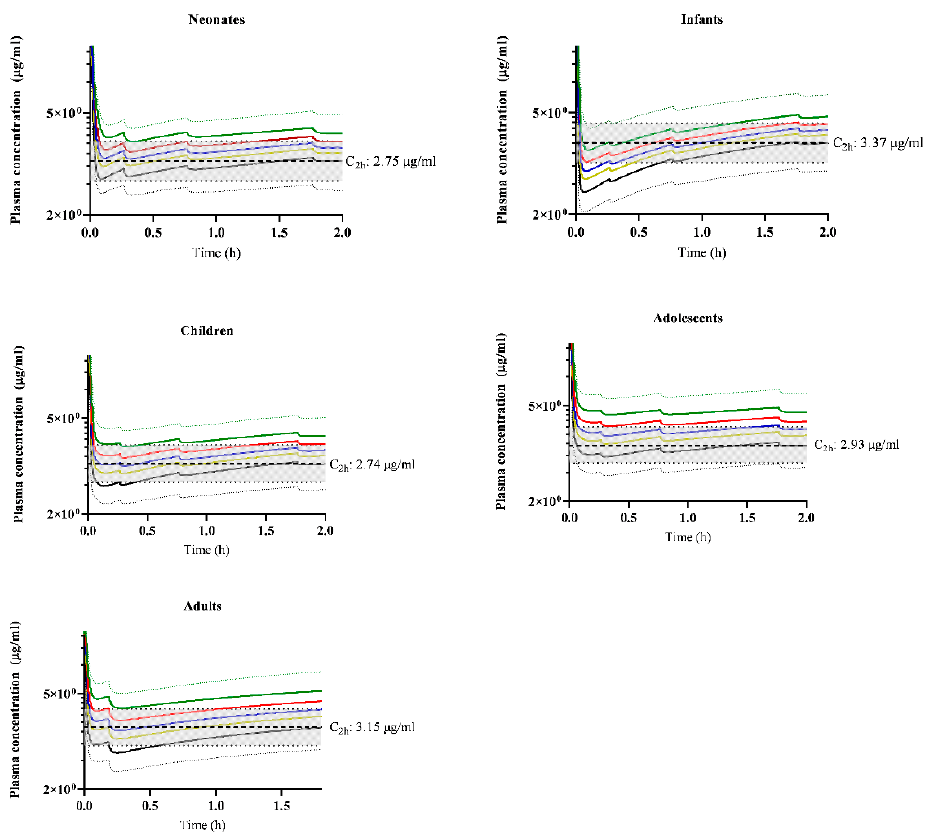
Figure 3. Simulated propofol plasma concentrations under various cardiac output conditions. Solid green, red, blue, yellow and black lines represent the predicted mean plasma propofol concentration under 50%, 40%, 30%, 20% and normal cardiac output (CO) conditions, respectively. Dotted green and black lines represent the predicted 95th and 5th percentile of the highest and least predicted mean concentration. The bold black dashed line is plasma concentration achieved at 2 h and the grey shaded area bordered by a thin black dashed line is 80–125% of target plasma concentration achieved at 2 h.